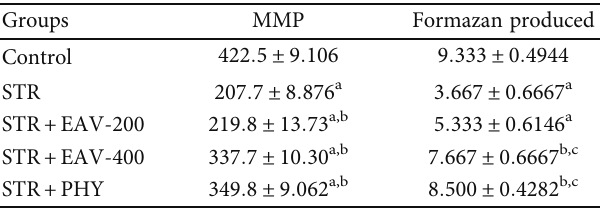
Figure 5: Graph showing changes in the mitochondrial function in terms of the level of formazan produced in MTT assay and changes in the integrity in terms of the fl uorescence intensity of TMRM. All values are mean ± SEM ( n = 6 ). a P < 0 : 001 , b P < 0 : 001 compared to control and STR, respectively (one-way ANOVA followed by Student – Newman – Keuls post hoc test), c P < 0.001 compared to STR + EAV-200. Table 7: Changes in the level of formazan produced in the MTT